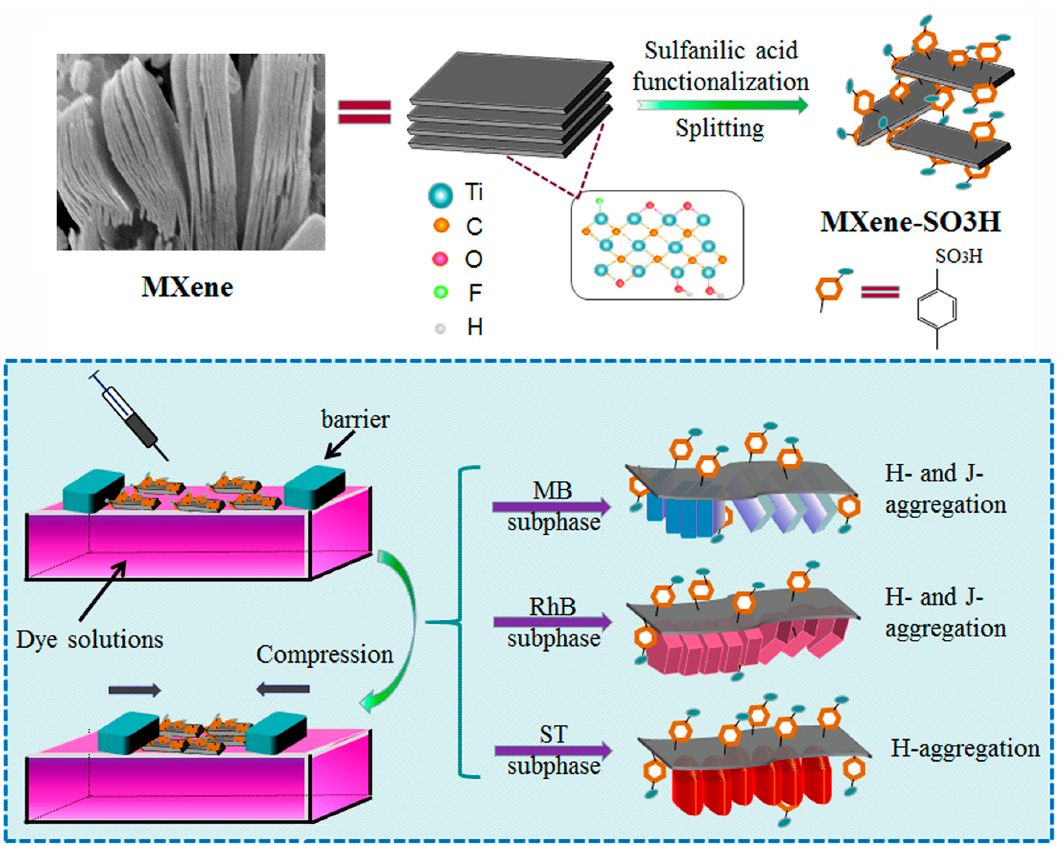
Figure 10. Schematic illustration of preparation of MXene-SO3H and interfacial self-assembly process of MXene-SO3H/dye composite Langmuir films as well as aggregation model of dye on MXene-SO3H surface.